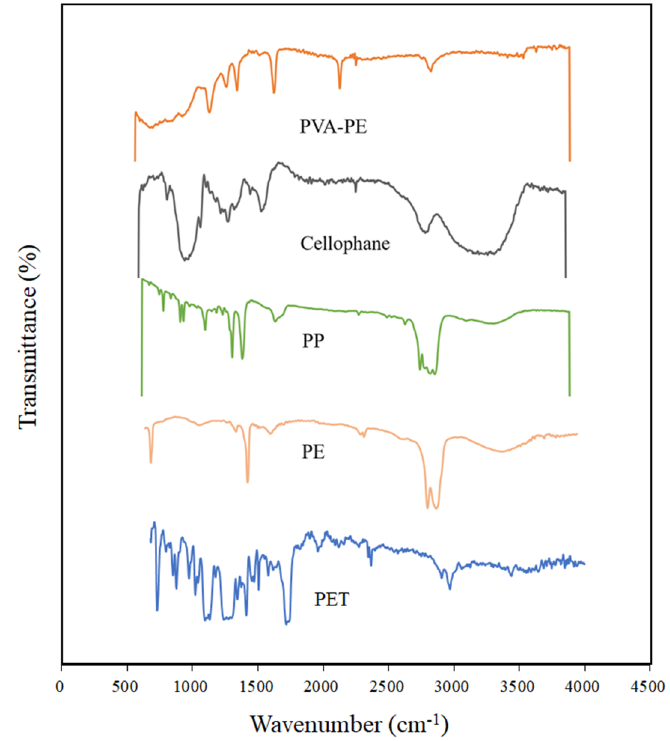
Figure 2. FTIR spectrum of some typical plastic particles collected in this study.